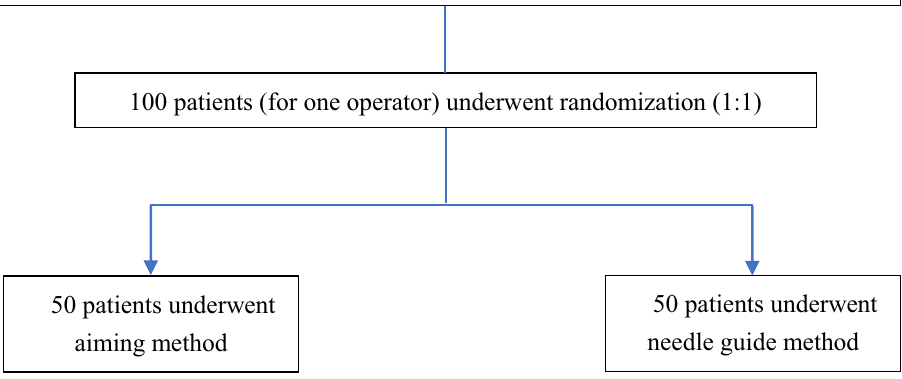
Figure 1. The CONSORT flow diagram of the study. Flow diagram of study subjects receiving an ultrasound- guided in-plane cannulation of the subclavian vein by aiming method or needle